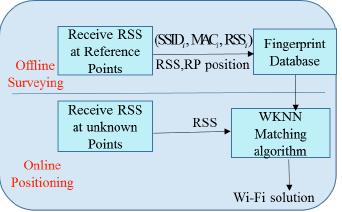
Figure 2 . Fingerprinting-based Wi-Fi positioning